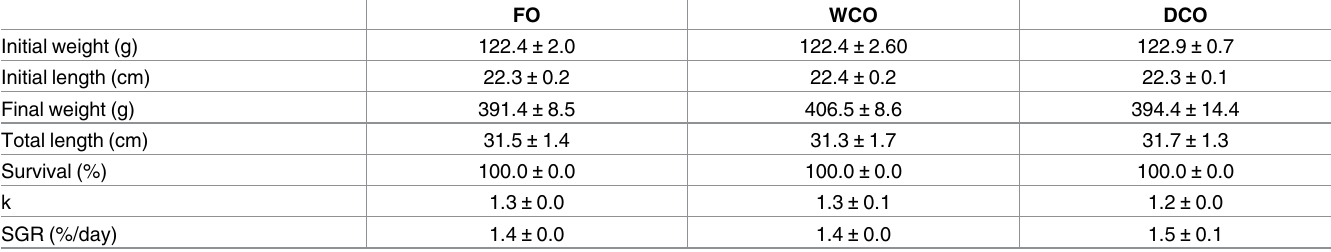
Table 2. Fish performance and survival over the 12-weekexperimental